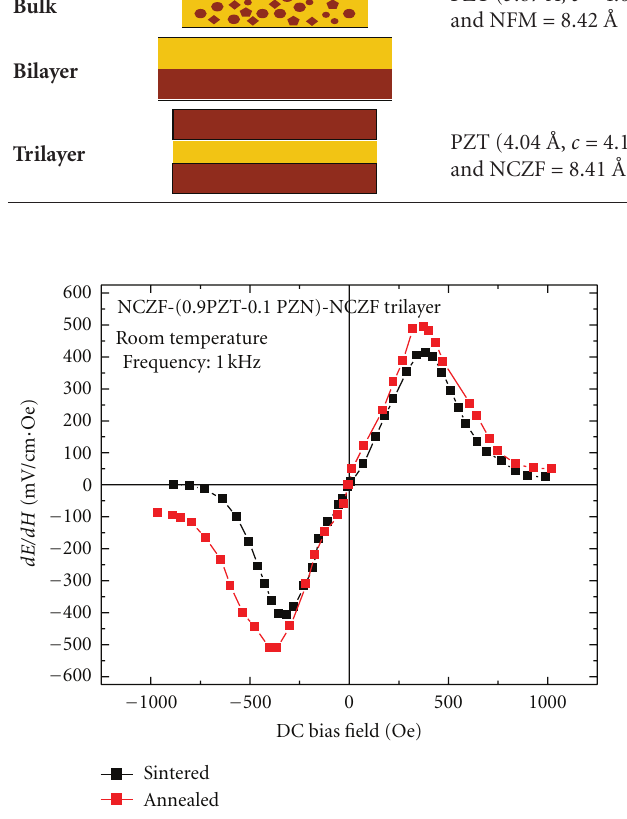
Figure 15: Magnetoelectric coe ffi cient as a function of dc bias